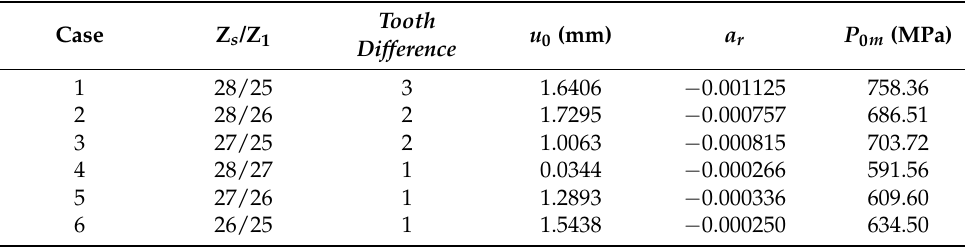
Table 8. Optimization results for different tooth